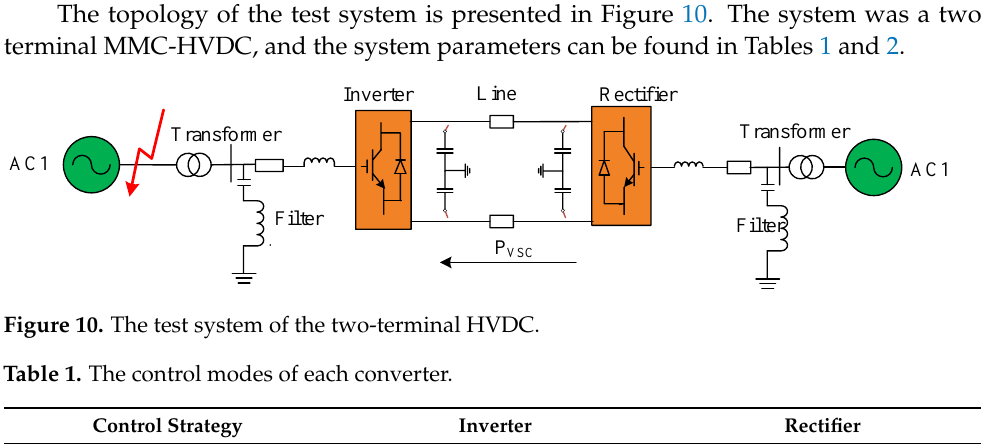
Figure 9. The transient fault current control scheme.